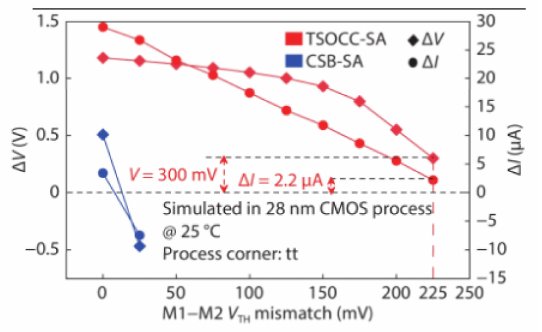
Figure 14. Simulated ∆ V and ∆ I vs. VTH mismatch between transistors M1 and M2